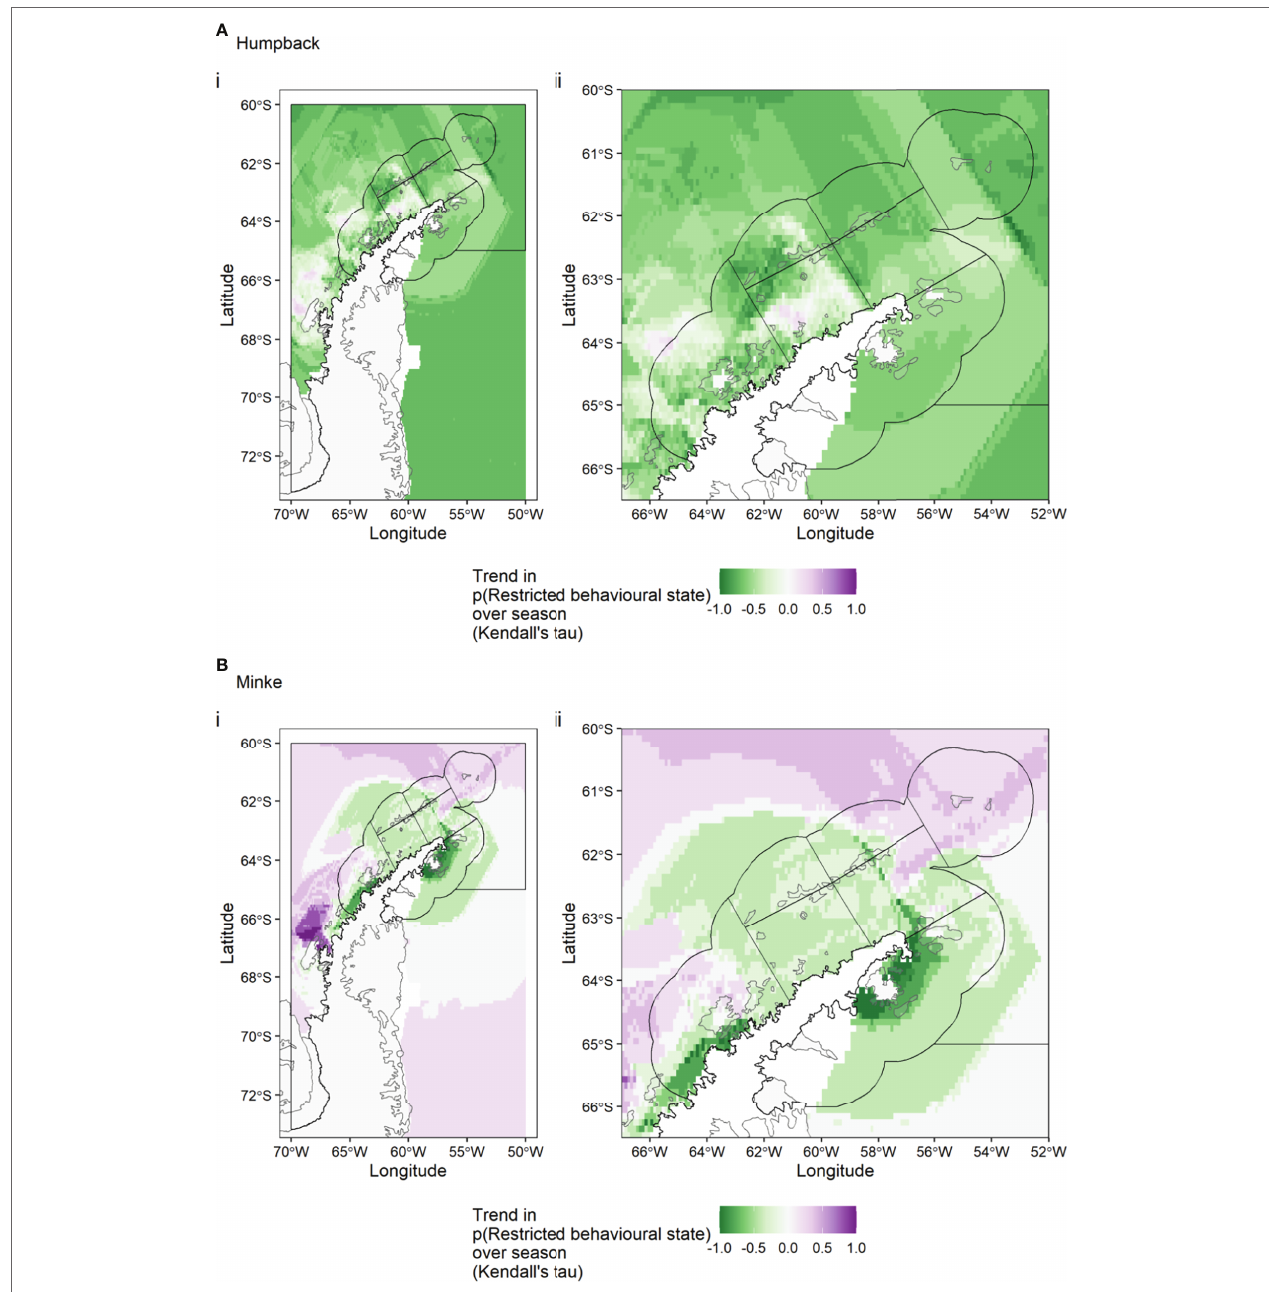
FIGURE 3 | For humpback whales (A) and minke whales (B) , the trend in behavioural state predictions over the season. A negative trend (green colours) means that, in a given grid cell, whales were decreasingly likely to be in a restricted behavioural state as the season progressed, while a positive trend indicates the